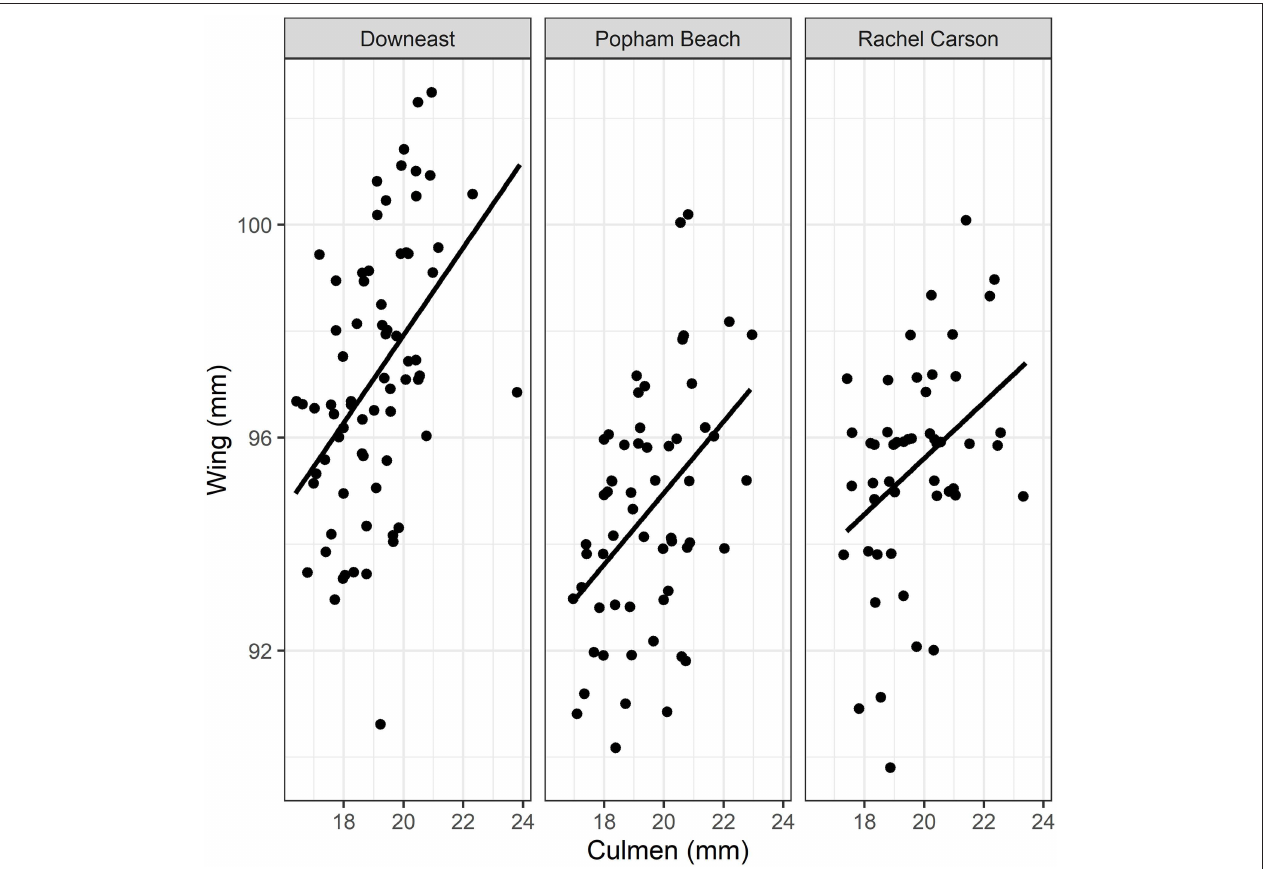
FIGURE 2 | Relationships between flattened wing length (to nearest 0.5mm) and bill culmen (to nearest 0.5mm) for Semipalmated Sandpipers (ages, years pooled) captured at each of the three study locations. While there was no difference across each site, in either metric, birds captured at the Downeast site had smaller culmens, but larger wings than those captured at Popham Beach and Rachel